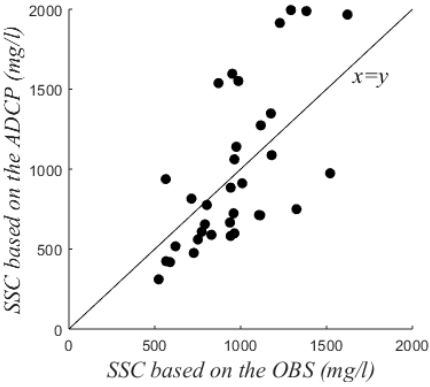
Figure 3. Tidally-averaged Suspended Sediment Concentration (SSC) at 30 cm above the bed based on Acoustic Doppler Current Profiler (ADCP) vs Optical Backscatter Sensor (OBS) measurements. Acoustic Doppler Current Profiler (ADCP) vs Optical Backscatter Sensor (OBS)